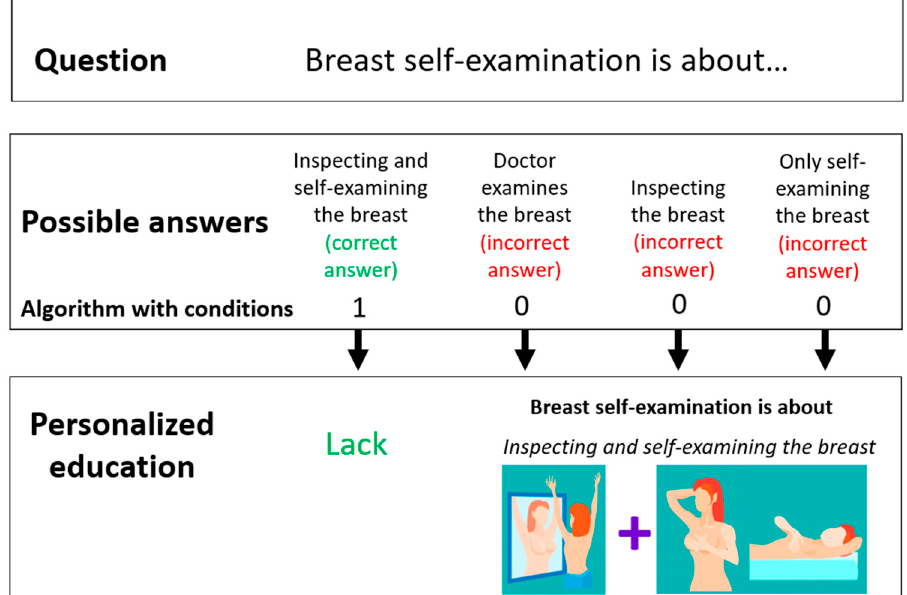
Figure 2. Principles of the intervention operation based on one of the questions.